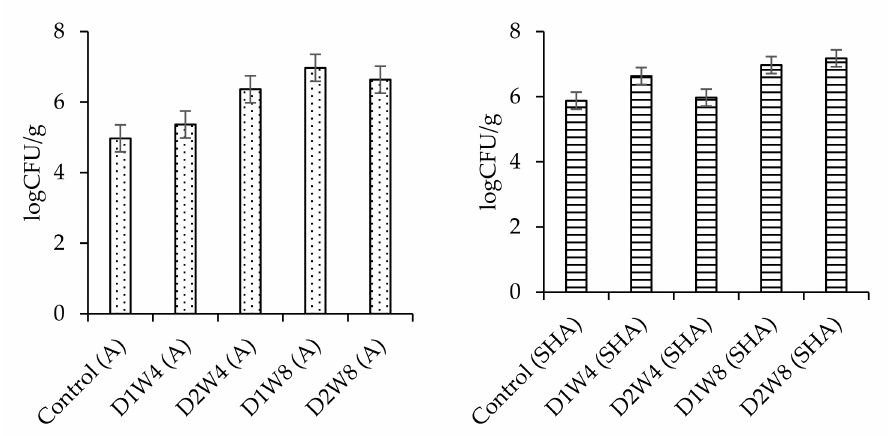
Figure 7. Number of aerobic bacteria, number (log CFU/g) of Arenosol and slightly humous Arenosol. The codes means the following treatments: Control (A): Control Arenosol. D1W4 (A): Dose 1 week 4 (Arenosol). D2W4 (A): Dose 2 week 4 (Arenosol). D1W8 (A): Dose 1 week 8 (Arenosol). D2W8 (A): Dose 2 week 8 (Arenosol). Control (SHA): Control slightly humous Arenosol. D1W4 (SHA): Dose 1 week 4 (slightly humous Arenosol). D2W4 (SHA): Dose 2 week 4 (slightly humous Arenosol). D1W8 (SHA): Dose 1 week 8 (slightly humous Arenosol). D2W8 (SHA): Dose 2 week 8 (slightly humous